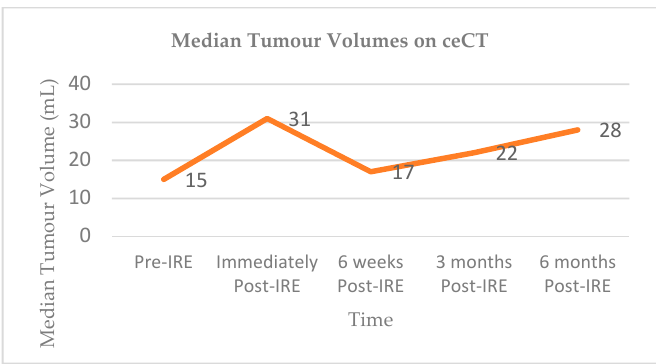
Figure 2. Median tumour volumes on contrast enhanced CT (ceCT).